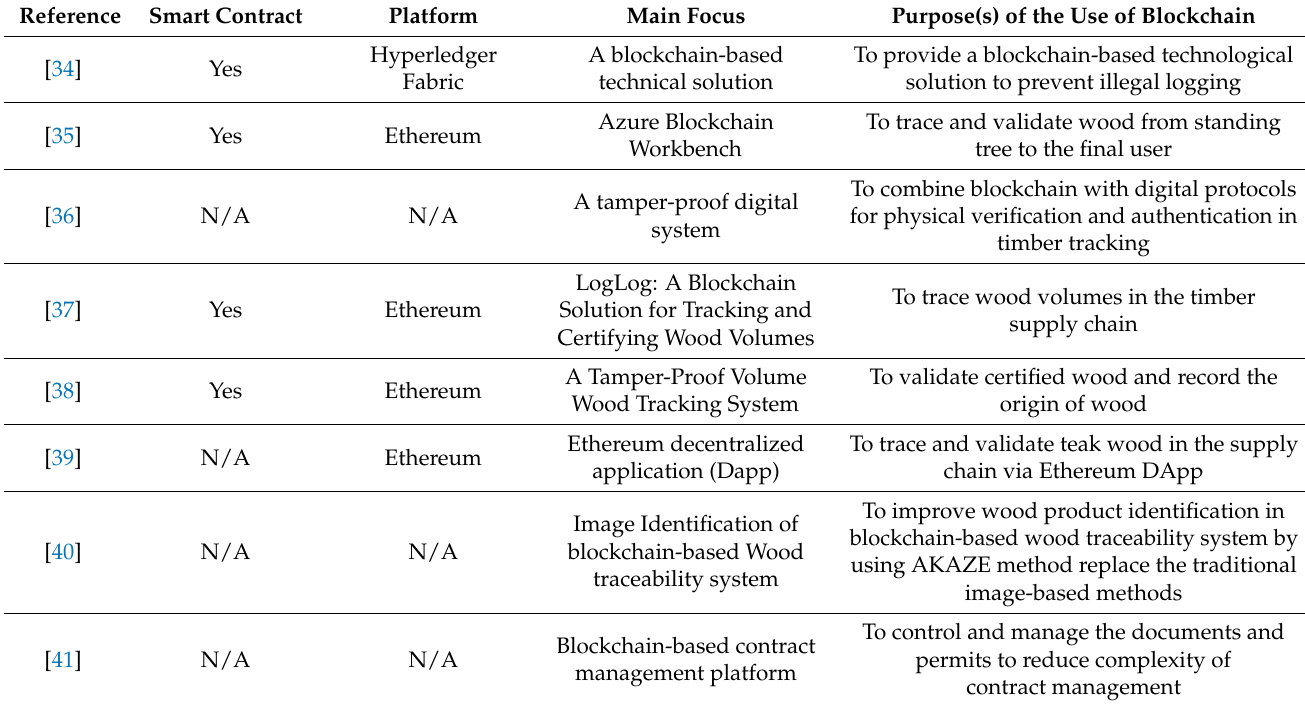
Table 2. Blockchain-based applications in the traceability of wood